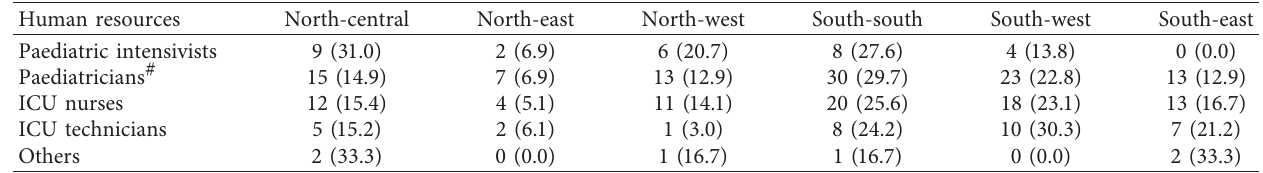
Table 5: Distribution of intensive care human resources in various zones of Nigeria ∗ .